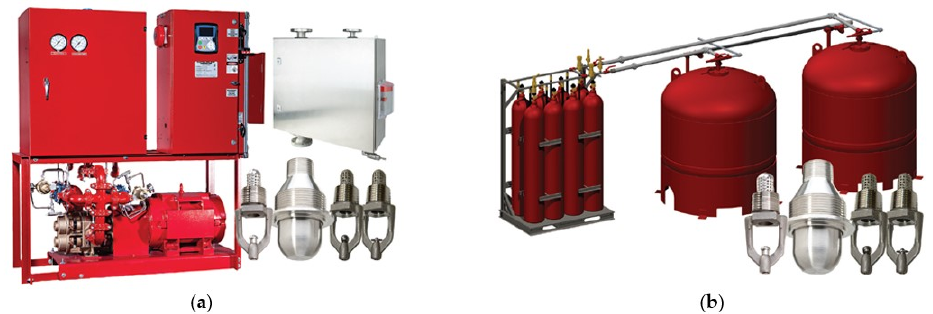
Figure 23. Typical components of an AquaMist ULF’s pumped water supply and stored